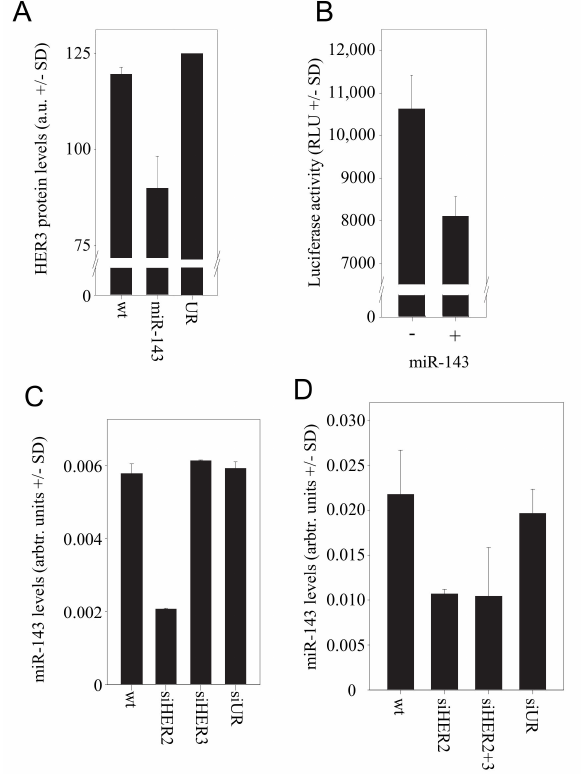
Figure 3. Role of miR143 in the HER2/HER3 regulation. ( A ) Effect of miR-143 transfection on HER3 protein levels. ( B ) HER3 is a direct target of miR-143 as determined in a luciferase reporter assay. ( C ) Upon siRNA-mediated HER2 knockdown, a marked reduction of miR-143 levels is observed. ( D ) MiR-143 levels in the tumor xenografts from the PEI/siRNA therapy